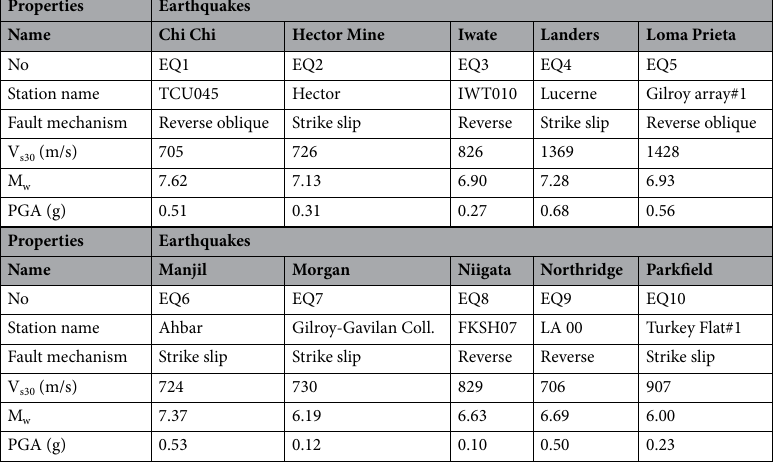
Table 4. Earthquake information 98